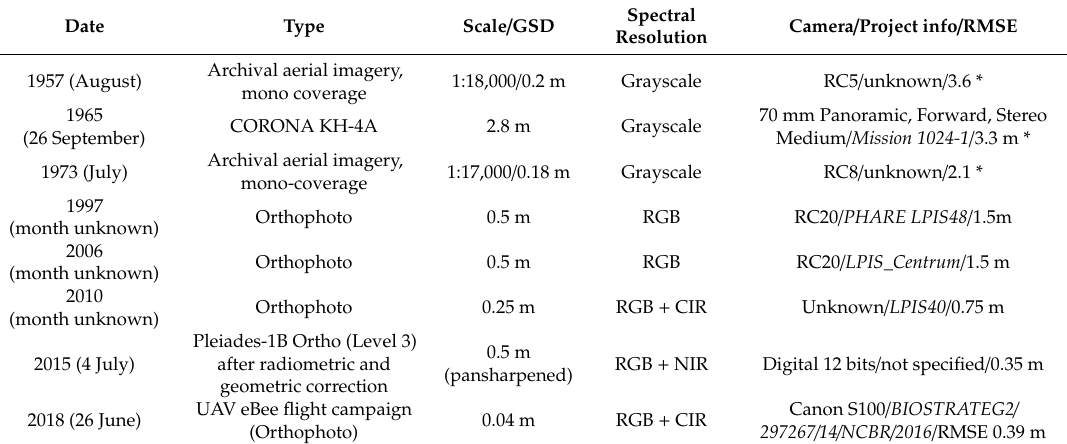
Table 1. The list of remote sensing imagery used for a multi-temporal case study of “K ó zki” nature reserve. GSD—ground sample distance.